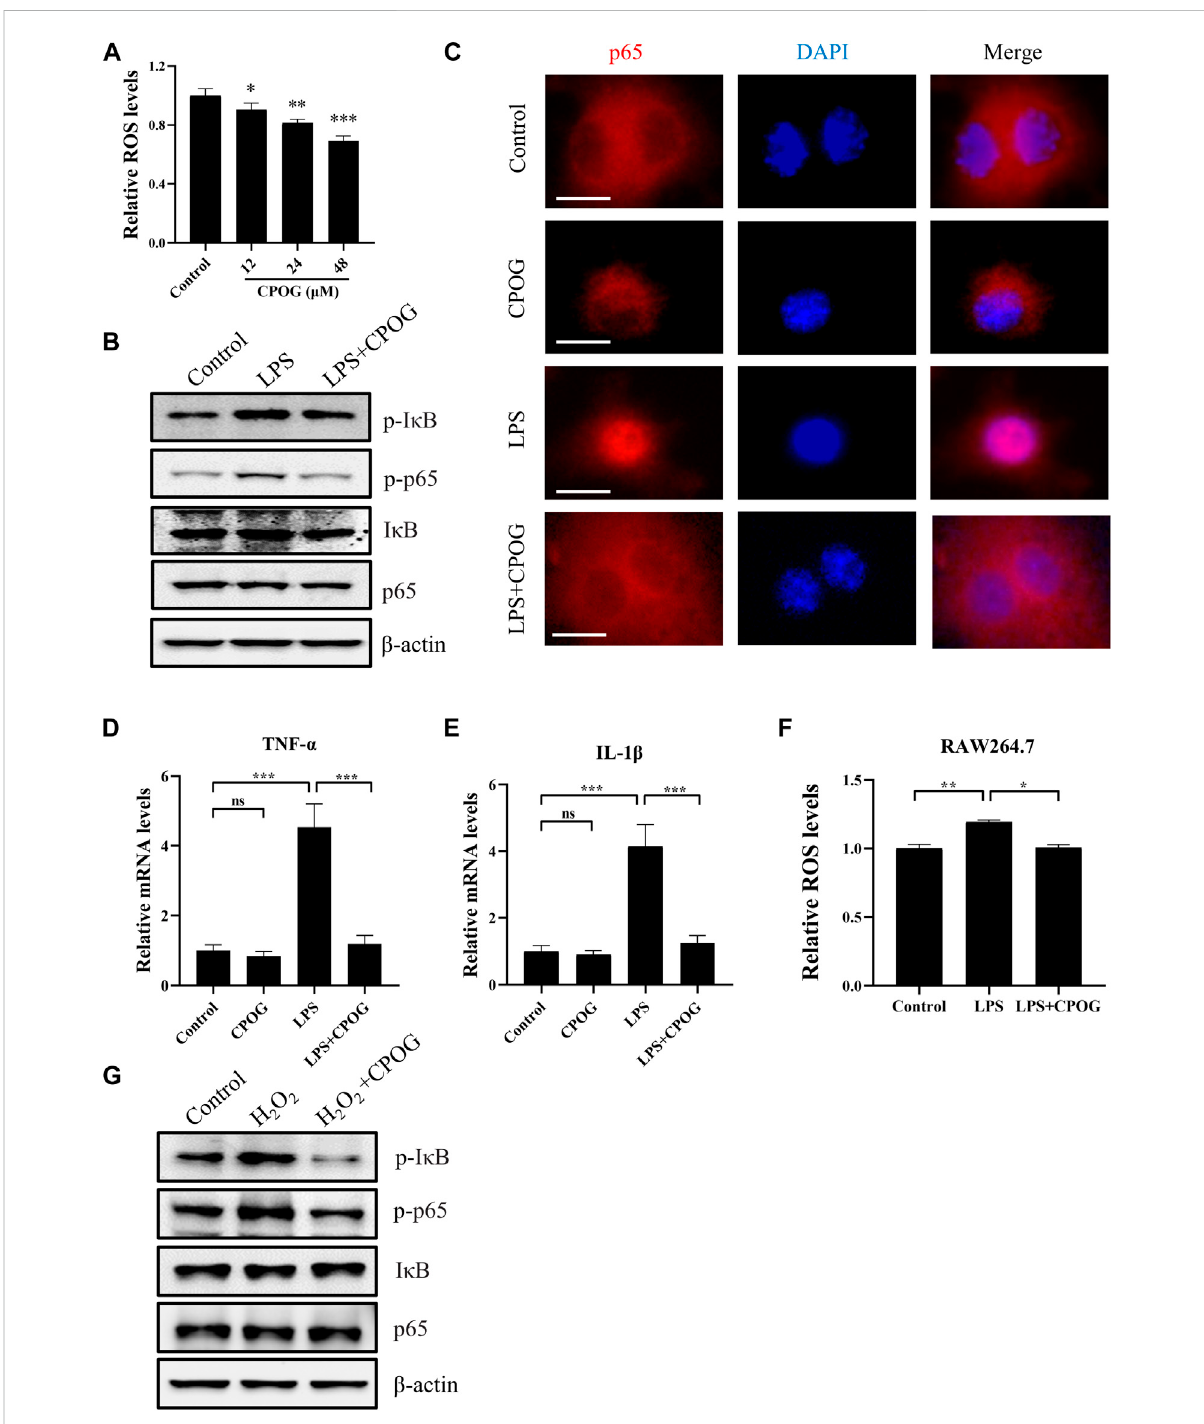
FIGURE 5 CPOG alleviated LPS-induced oxidative stress and in fl ammation response in RAW264.7 cells. (A) RAW264.7 cells were treated with indicated concentrations of CPOG and intracellular ROS level was detected with CM-H2DCFDA. (B – F) RAW264.7 cells were treated with 1 μ g/ml LPS in the presence or absence of 48 μ M CPOG for 4 h. The expression of indicated proteins was detected by Western blot (B) . p65 cell location was detected by immuno fl uorescence assay (C) . Expression of TNF- α (D) and IL-1 β (E) was detected by RT-PCR. Intracellular ROS level was detected with CM-H2DCFDA (F) . (G) RAW264.7 cells were incubated with 48 μ M CPOG for 4 h before treated with 500 μ M H 2 O 2 for 30 min. The expression of indicated proteins was detected by Western blot. Values represent mean ± S.D. Signi fi cance was determined by one-way ANOVA test. Data are representative of three independent experiments. * p < 0.05, ** p < 0.01, *** p <